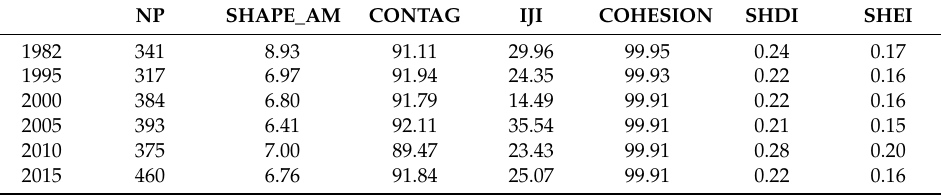
Table 7. Landscape-level metrics for forestlands in the Naoli River